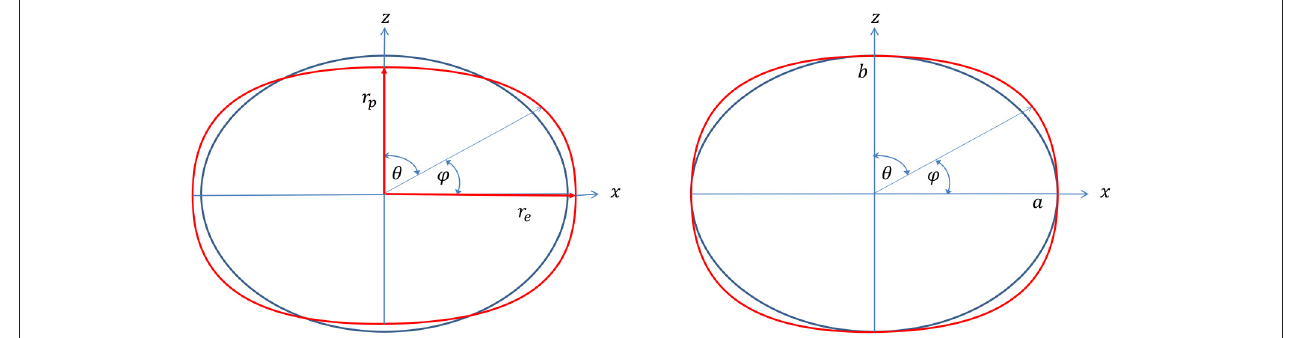
a , r p b . The right panel shows the most important physical case of 6= 6= ϕ 90 ◦ 90 ◦ ), − ≤ ≤ B 2 θ π ). In general, when B 1 0 , ≤ ≤ 6= 6=